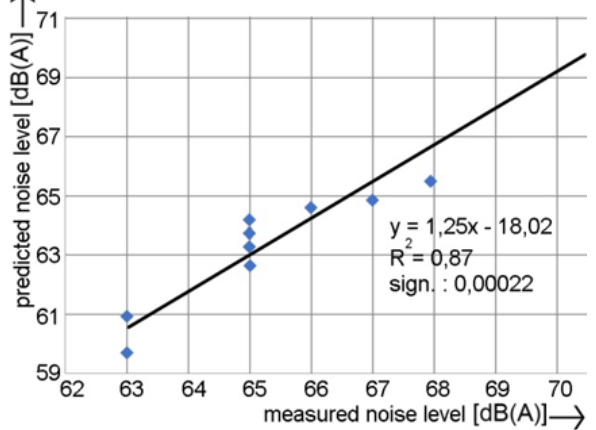
Figure 14: Predicted vs. measured road traflcnoise (L A 10 ) along the façade of “Apollon”. R 2 : correlation coeflcient squared,